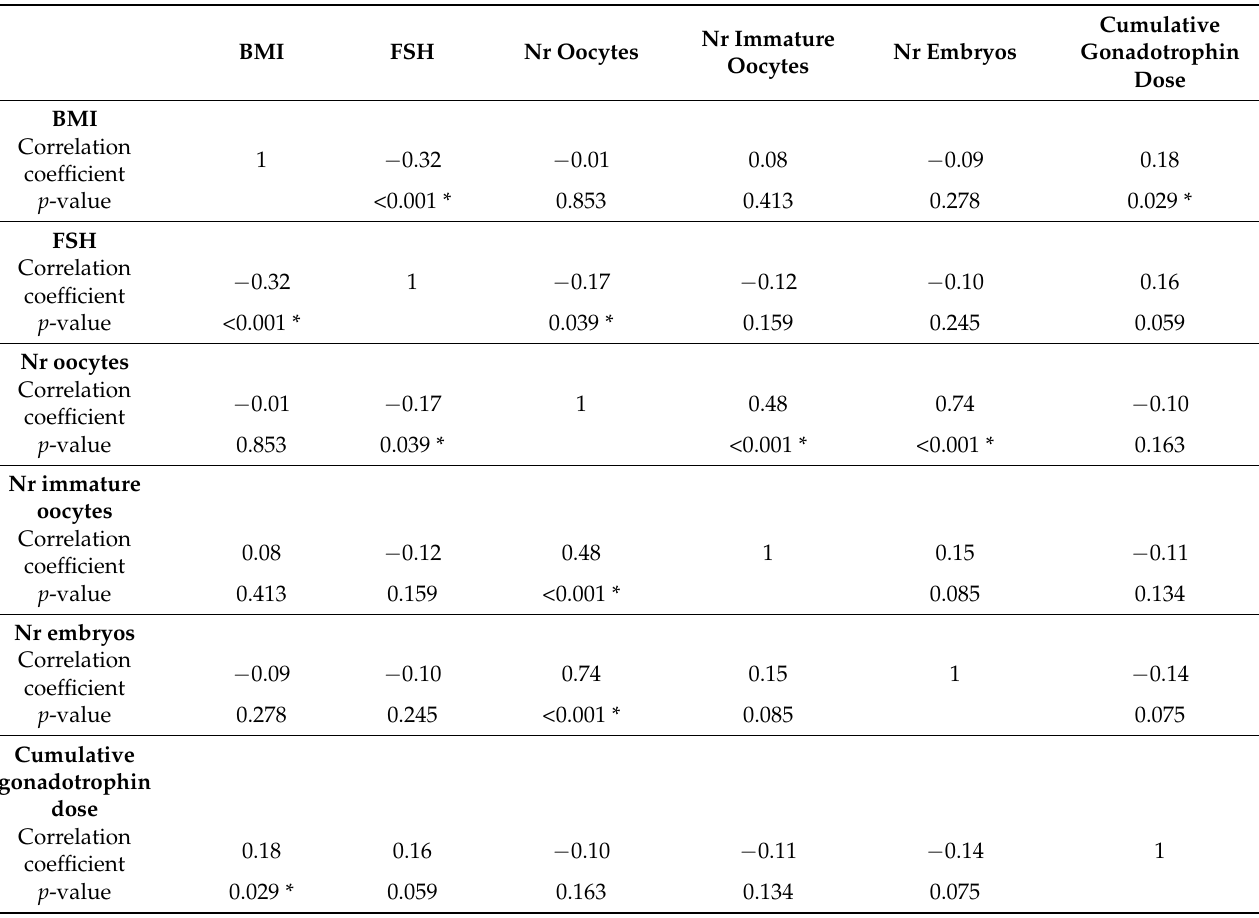
Table 3. Spearman’s correlation for all patients. Statistically significant differences are marked with an asterisk ( p -value <